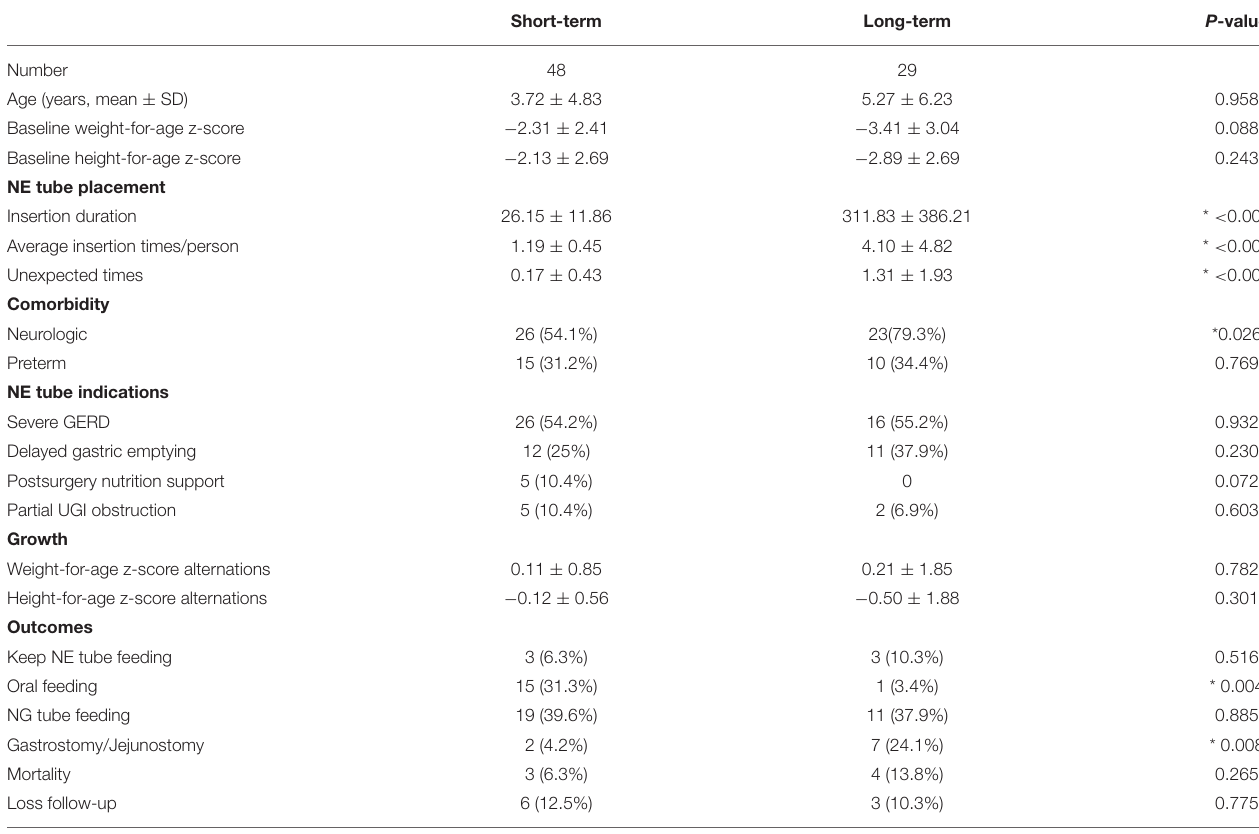
TABLE 3 | Short- ( < 8 weeks) and long-term ( > 8 weeks) use of NE tube feeding.